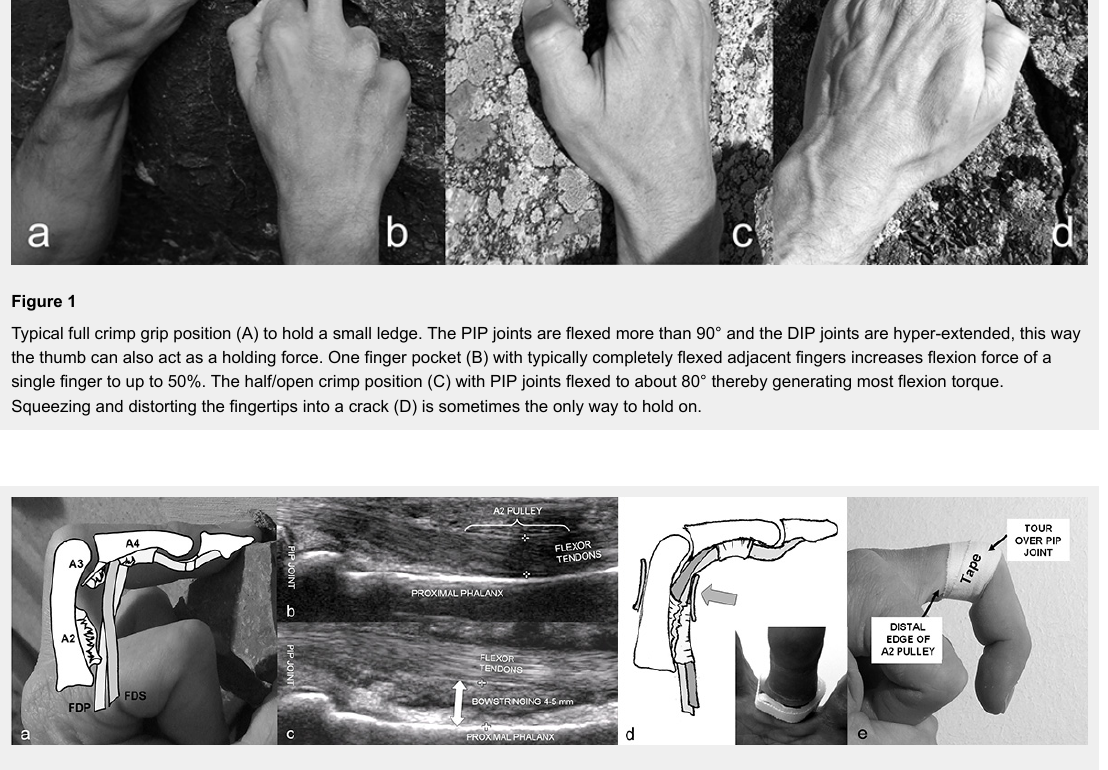
Figure 2 Finger flexor tendon sheath (A) with complete disruption of the A2 and the A3 pulley, partial disruption of the A4 pulley leading to bowstringing of the deep (FDP) and the superficial (FDS) flexor tendons. Ultrasound view of the normal anatomy (B) and of a disrupted A2 pulley (C) with an apparent bowstringing of the flexor tendons. A pulley protection ring (D) brings the flexor tendon back to normal position. Properly applied pulley tape (E) prevents flexion of the PIP joint of more than